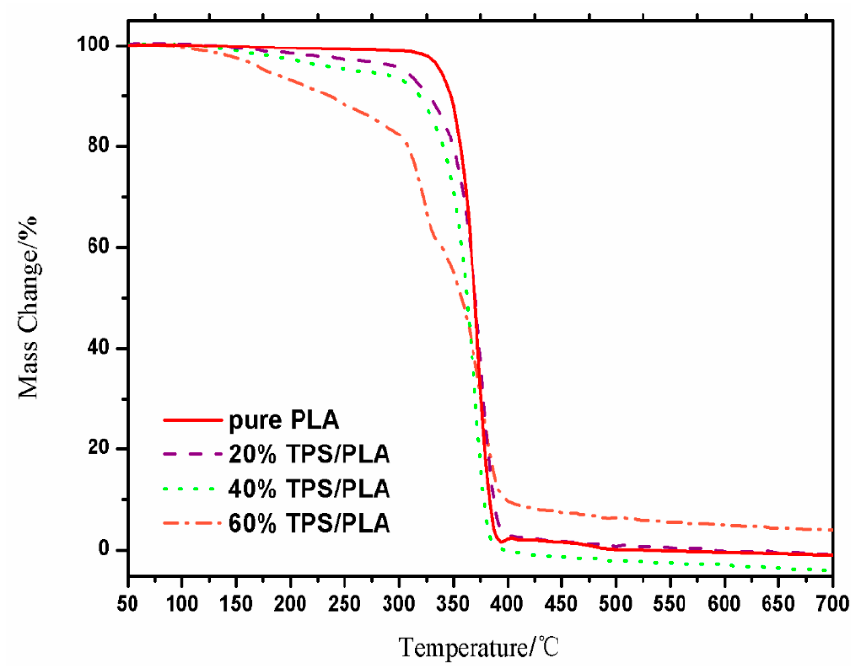
Figure 6. Thermal decomposition of TPS/PLA blend evaluated by thermal gravimetric analysis